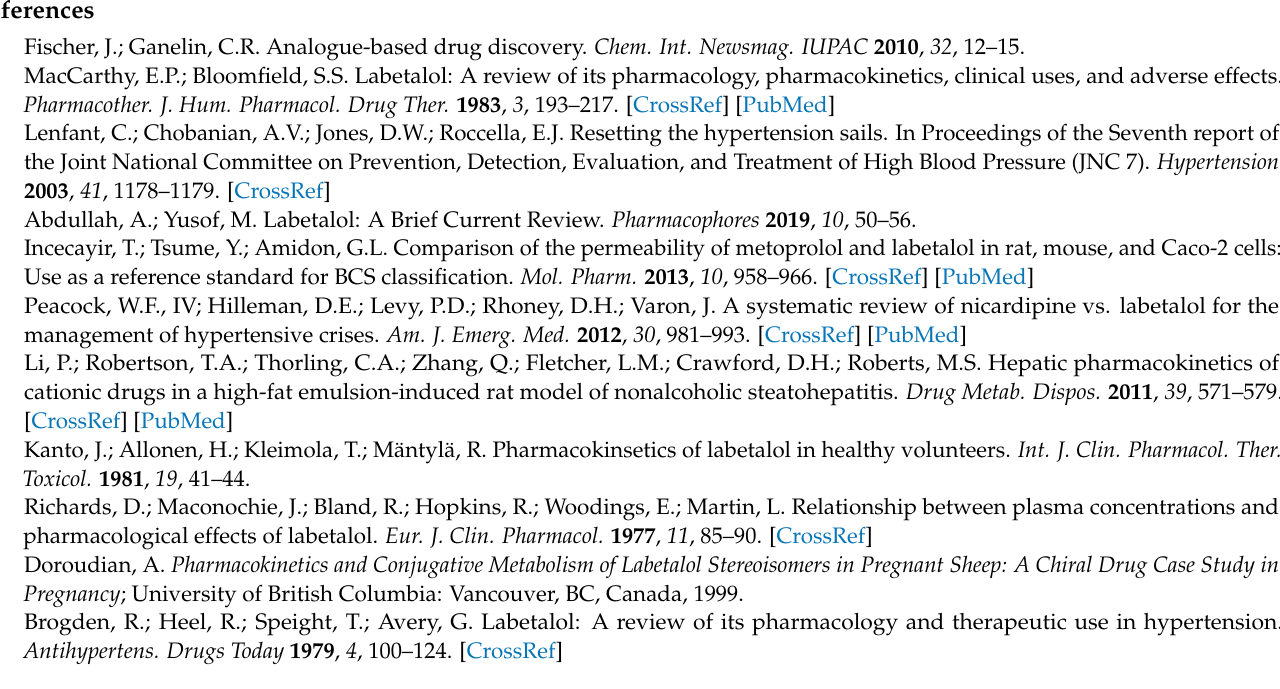
articles using Jadad scoring, Table S3. Quality assessment of included articles using CASP scoring, Table S4. Characteristics of the included studies, Table S5: Pharmacokinetic parameters of the intravenous studies, Table S6: Pharmacokinetic parameters of oral studies, Table S7: Pharmacokinetic parameters of diseased studies, Table S8: Influence of food of the pharmacokinetics of Labetalol, Table S9: Effect of enzyme induction and inhibition on labetalol pharmacokinetics, Table S10: Average fold Figure S1. Boolean Operators search strategy, Figure S2. PRISMA flow chat